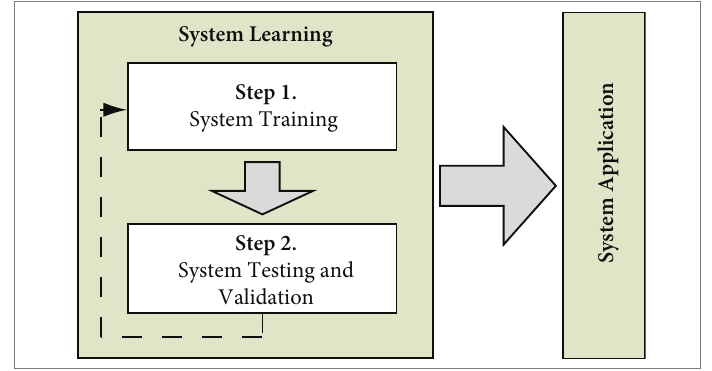
Fig. 2. System functioning